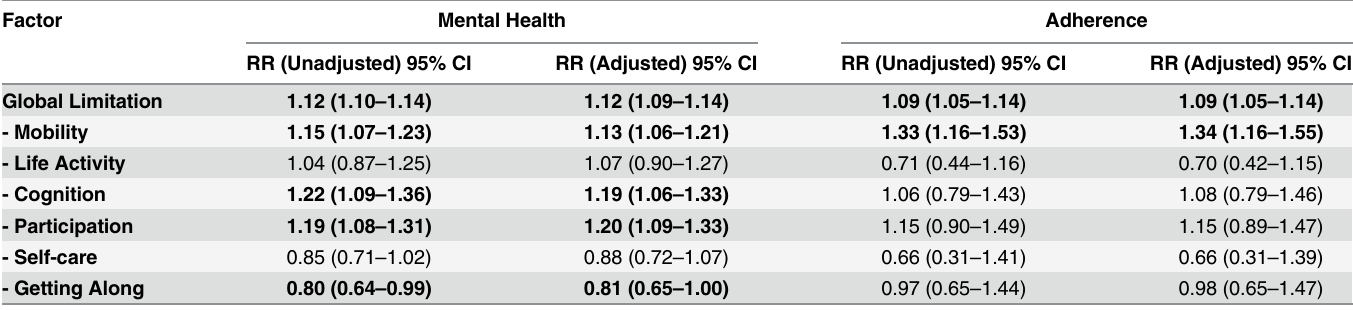
Table 2. Relative Risk